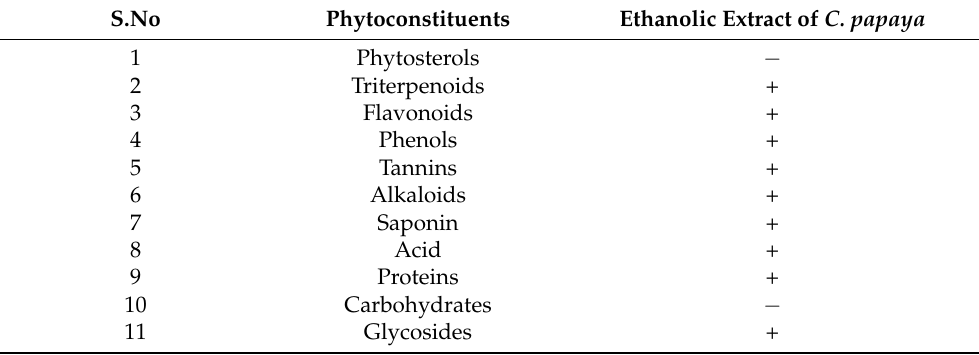
Table 3. Qualitative phytochemical screening of the ethanolic extract of C. papaya .